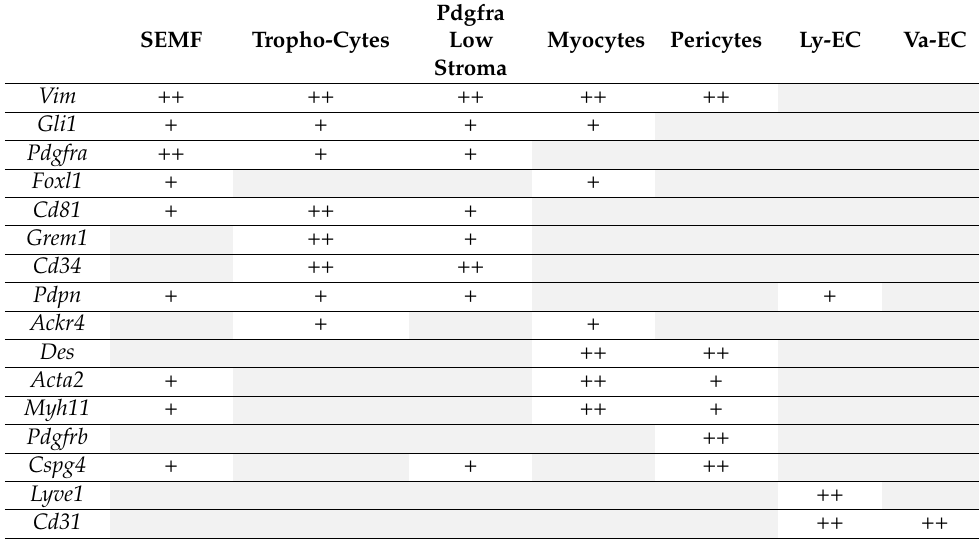
Table 1. Populations of intestinal mesenchymal stromal and endothelial cells. Expression of molecular markers in defined cell types based on bulk and scRNA-Seq studies. The number of “+” reflects their expression levels, while grey background indicates the lack of expression. SEMF—subepithelial myofibroblasts or telocytes; Ly-EC—lymphatic endothelial cells; Va-EC—vascular endothelial cells. Pdgfra SEMF Tropho-Cytes Low Myocytes Pericytes Ly-EC Va-EC Stroma Vim ++ ++ ++ ++ ++ Gli1 + + + + Pdgfra ++ + Foxl1 + ++ + Grem1 ++ + Cd34 ++ + Ackr4 + + Des ++ ++